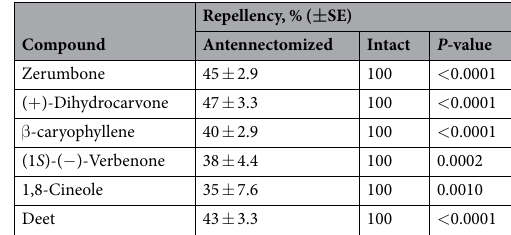
Table 5. Repellency of five pure organic compounds and commercial repellent deet to antennectomized and intact male Blattella germanica using an Ebeling choice box assay at 652.4 μ g cm − 2